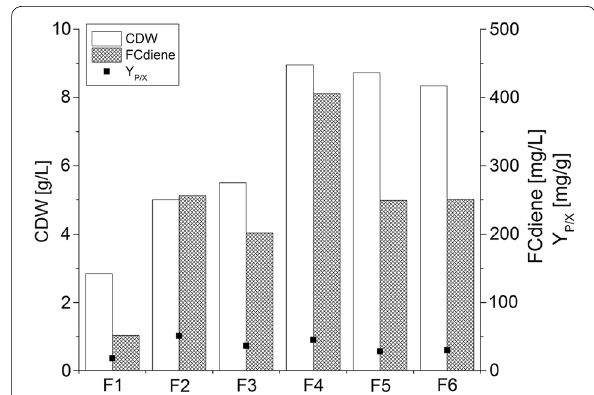
Fig. 4 Comparison of batch and fed-batch fermentations: Fermentations in a KLF2000 fermenter (working volume 1.8 L), using glucose as a carbon source with unregulated pH. Cell growth and FCdiene concentrations with calculated cell specific product yield are shown. F1: Batch fermentation, F2: Fed-batch fermentation with manual feed, F3: Fed-batch fermentation with controlled feed and variable stirrer speed, F4: Fed-batch fermentation with controlled feed and staircase-shaped stirrer profile, F5: Fed-batch fermentation with controlled feed and linear stirrer profile, F6: Optimized fed-batch